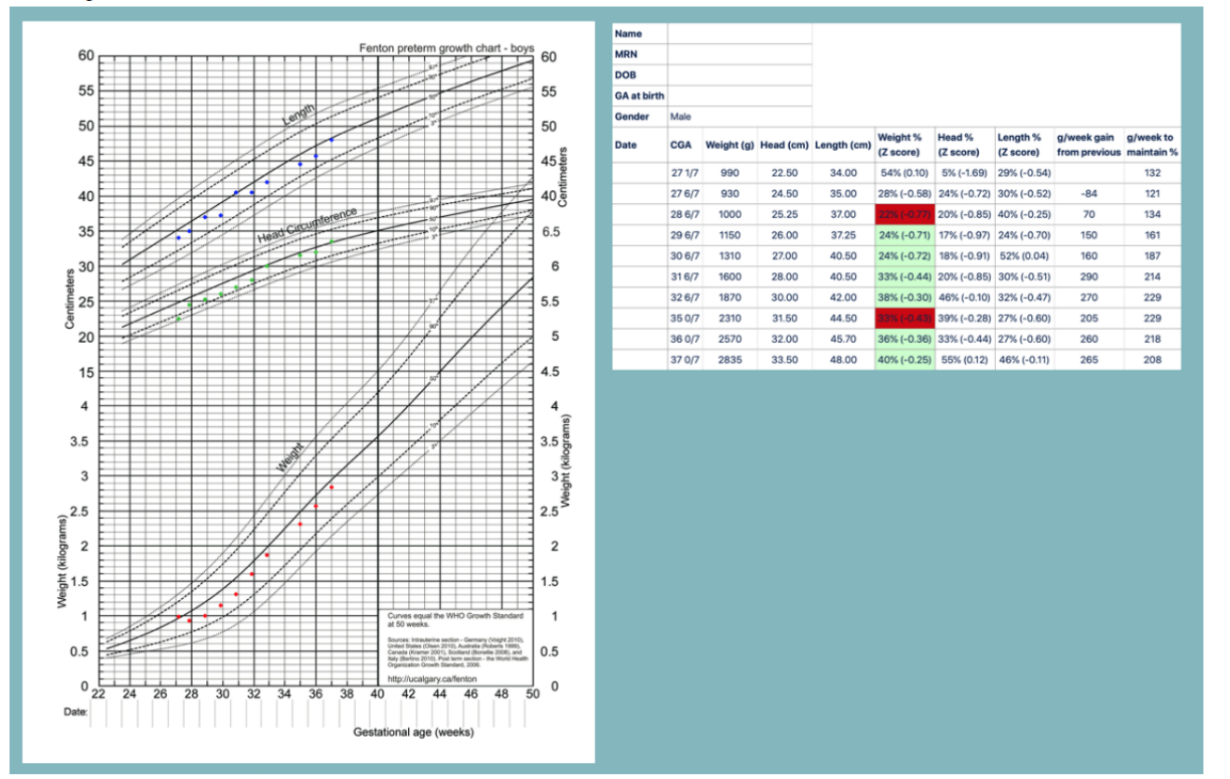
Figure 4. Electronic Fenton 2013 preterm growth chart. De-identified demographic and anthropometric data is copied into a webpage form from a specifically designed Microsoft Excel™ spreadsheet. The upper panel shows each anthropometric measurement plotted automatically onto the traditional paper-based chart. The lower panel displays calculated percentiles, Z-scores, and weekly weight change, both the actual observed change as well as the expected weekly change needed to maintain the previous percentile. Clinical decision support is provided by color-coding based on the weekly weight Z-score